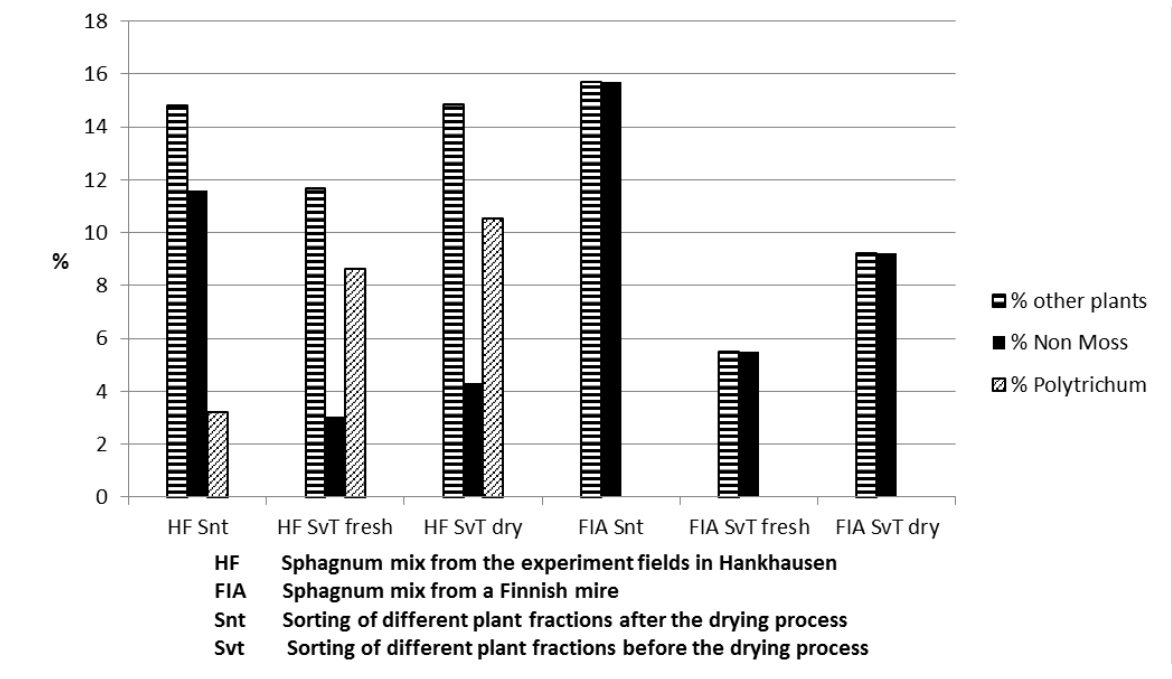
Figure 3. Non-S phagnum fractions as percentage by weight.